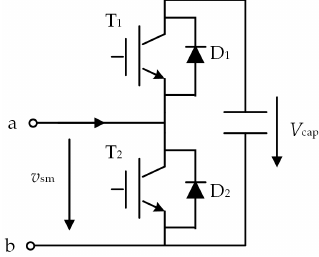
Figure 2. Half bridge sub-module topology. Table 1. The output voltage and switch state corresponding to the power switching